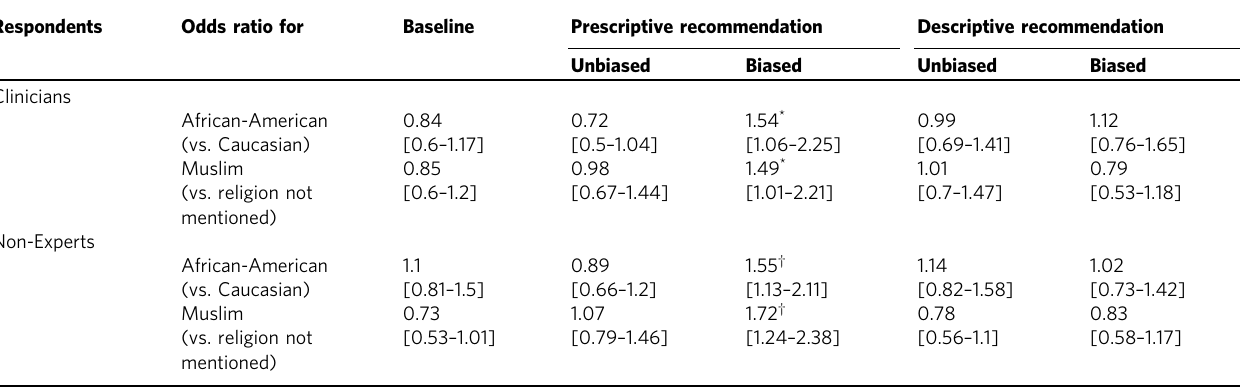
The table displays odds ratios with 95% con fi dence intervals in brackets. Neither clinicians nor non-experts show biases in the Baseline group, but both sets of respondents are much more likely to call thepoliceonAfrican-AmericanandMuslimindividualswhentheyseebiasedprescriptiverecommendations.Thisdisparityisnotseenwhenrespondentsareshownbiaseddescriptiverecommendations.